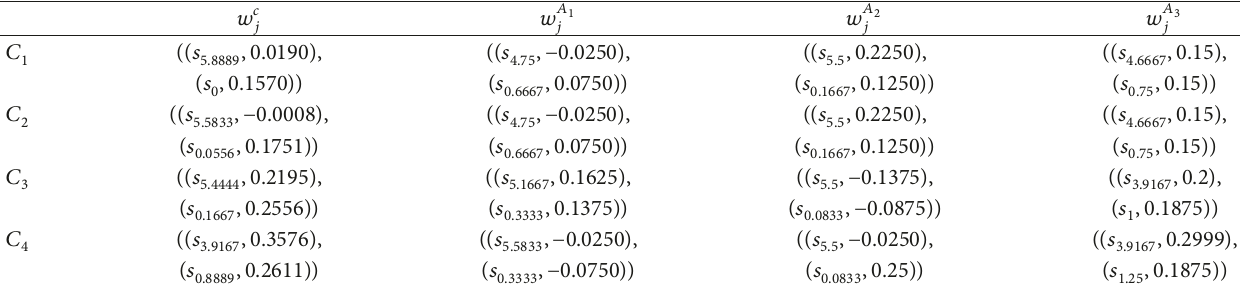
Table 7: Over all aggregated weights of alternatives and